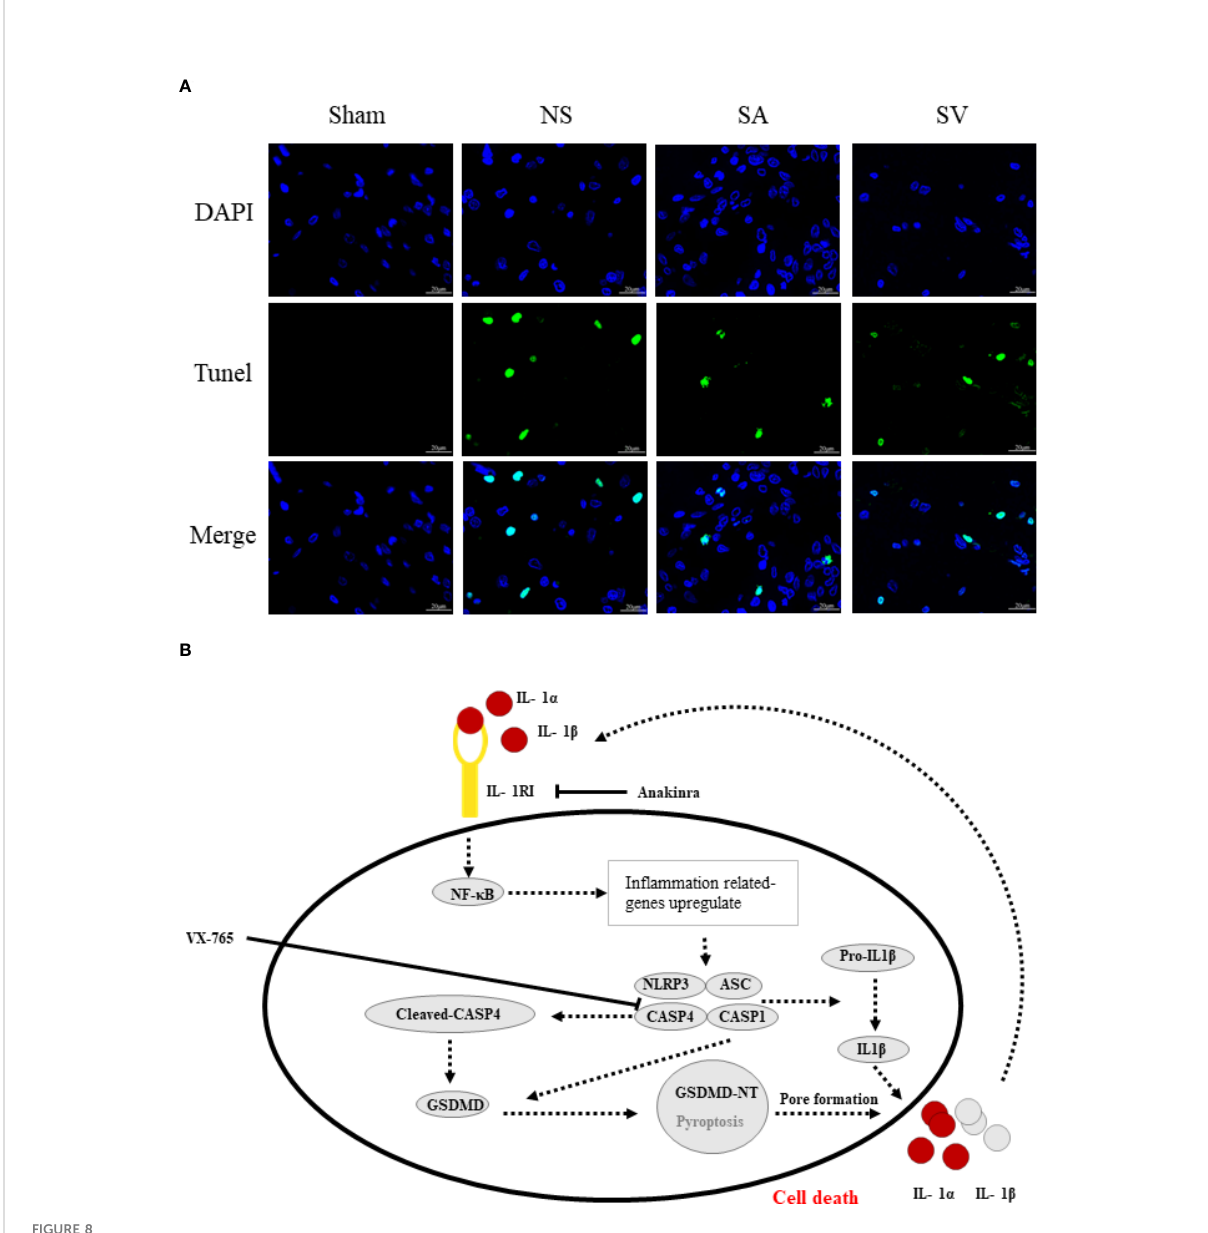
FIGURE 8 The therapeutic effect of the targetable drugs and exploration of the mechanism of spinal cord injury based on the biomarkers. (A) Veri fi cation of the therapeutic effect of Anakinra and VX765 for SCI by TUNEL staining (Scale bars = 20 m m) (n = 3 rats per group, *p < 0.05, **p < 0.01, t- test). (B) Speculation for the pathomechanism of